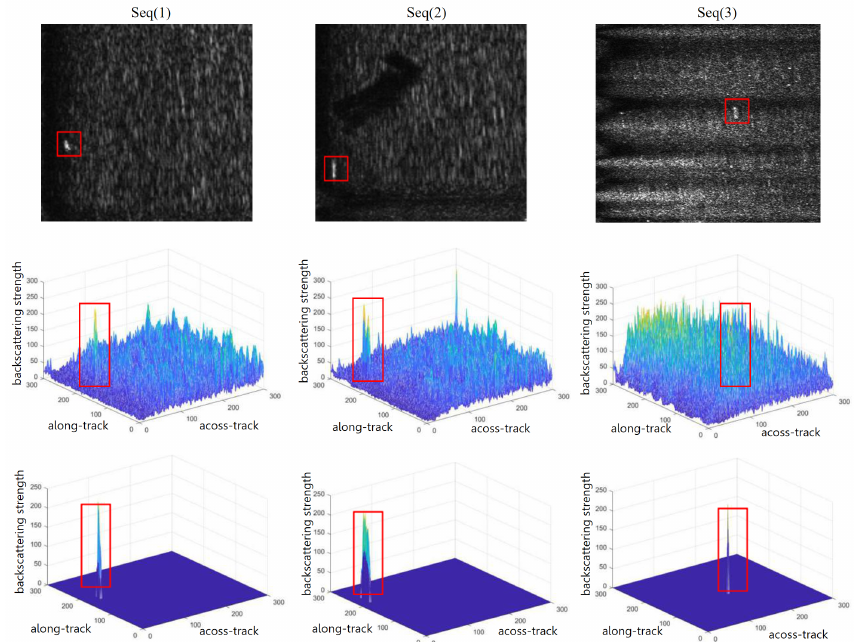
Figure 10. 3D visualization of the sonar image detection result. The first row shows three input sonar images (the red box in the image is the target), the second row shows the input SSS images plotted in 3D (across-track, along-track, and backscattering strength), and the third row shows the detection results plotted in 3D (across-track, along-track, and backscattering